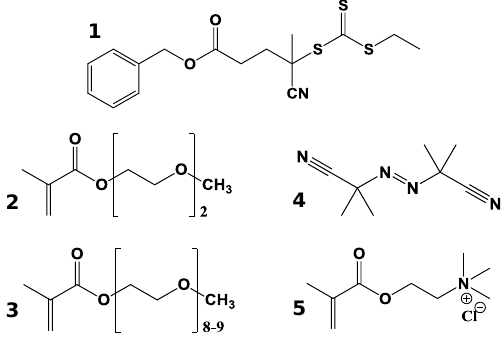
Figure 1. Structures of the reversible addition-fragmentation chain transfer (RAFT) chain transfer agent (CTA, 1 ); the monomers di(ethylene glycol) methyl ether methacrylate (DEGMA, 2 ), oligo(ethylene glycol) methyl ether methacrylate (OEGMA, 3 ) and trimethyl-2-methacroyloxyethylammonium chloride (TMEC, 5 ); and the initiator 2,2 (cid:48) Azobis(isobutyronitrile) (AIBN, 4